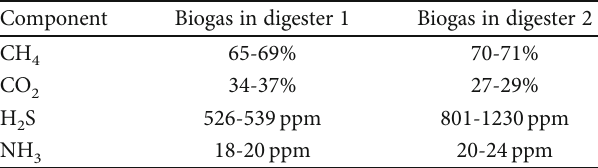
Figure 1: On-site experiment of biogas puri fi cation: photo (a) and schematic diagram (b). Table 1: Composition of biogas within two